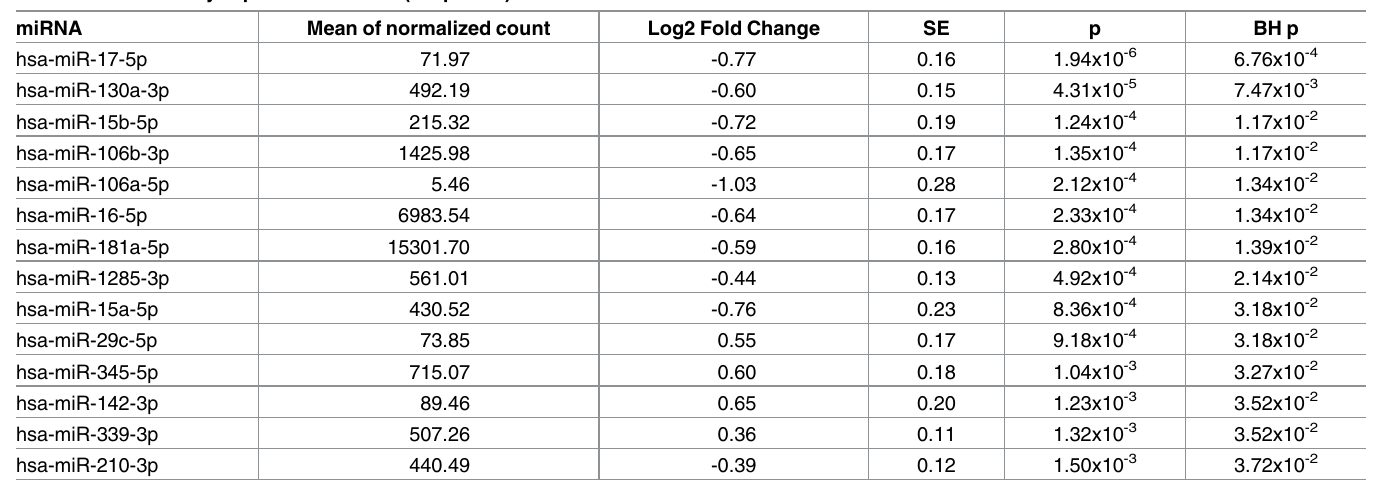
Table 2. Differentially expressedmiRNAs (BH p <